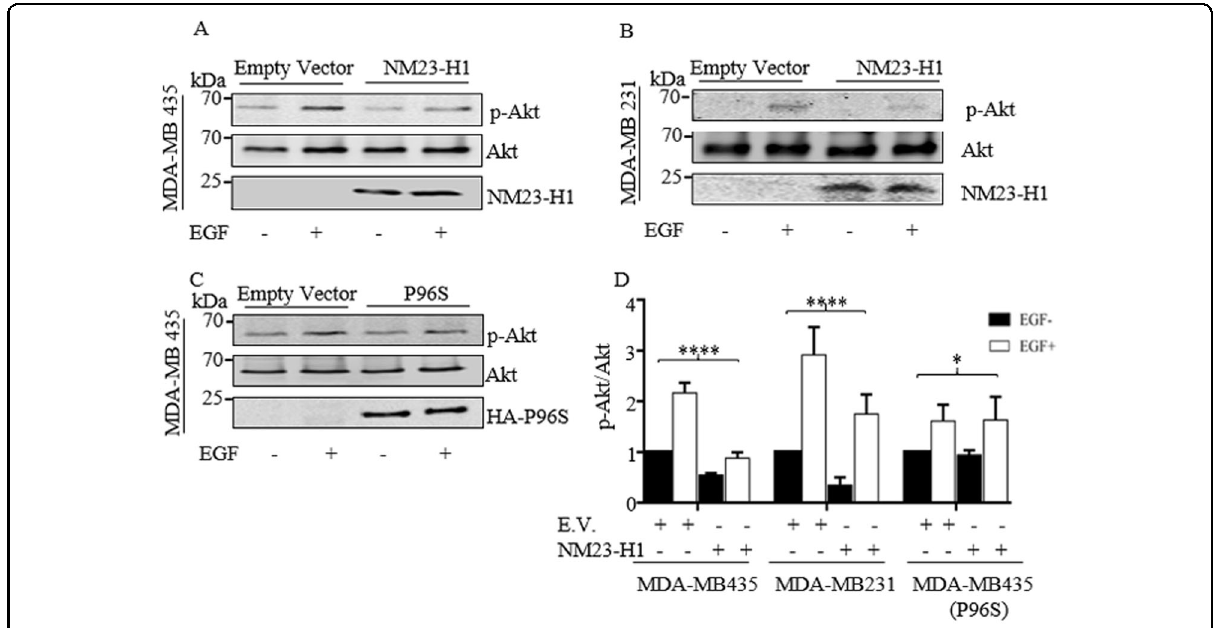
Fig. 4 NM23-H1 expression inhibit Akt phosphorylation upon EGF treatment of melanoma and TNBC (triple negative breast cancer) cells. MDA-MB-435 and MDA-MB-231 expressing Empty vector, NM23-H1 and MDA-MB-435 expressing the P96S mutant isoform were starved for 16 h and treated with EGF (20 ng/ml) or vehicle for 10 min. The p-Akt protein was evaluated by immunoblot densitometry analysis on MDA-MB-435 ( A ), MDA- MB-231 ( B ), and MDA-MB-435 P96S ( C ) and the expression were normalized relative to total Akt and represented in the bar graph ( D ). Fluorescent secondary antibodies were used, and quantitation was performed using a LI-COR system. T -test statistical analysis was performed. n = 3. (* p < 0.05; **** p <